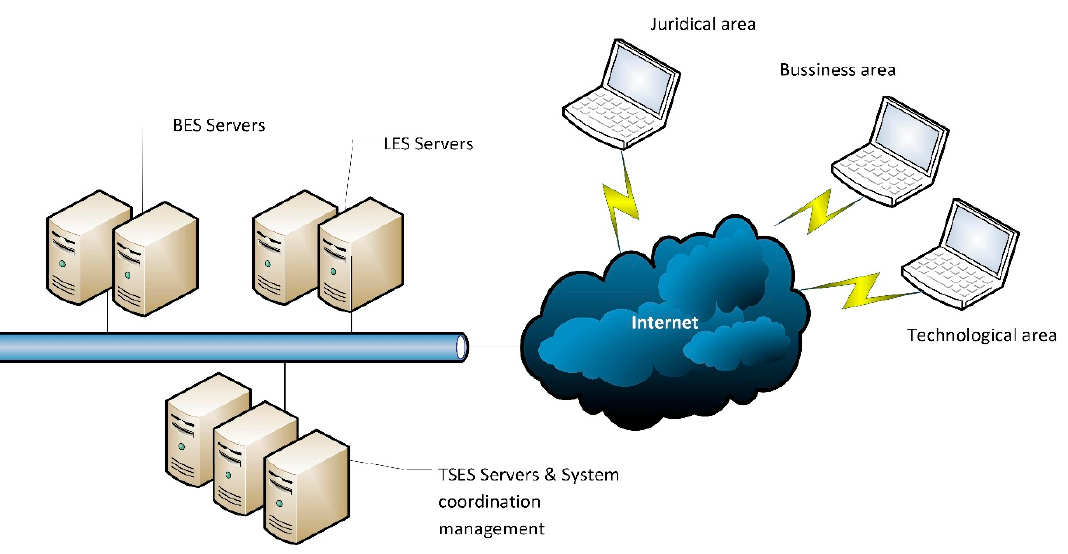
Figure 8. Expert System. Automatic Selection System for making decisions over security and privacy policies.